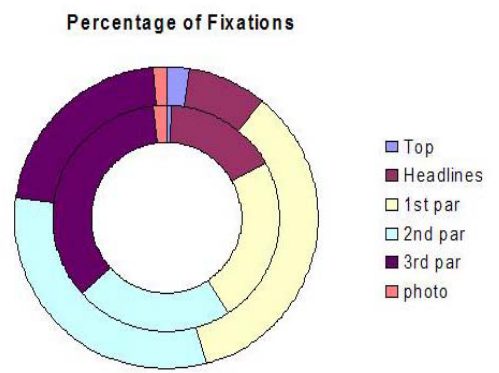
Figure 7 - Ring diagram that compares percentage distribution of fixations within AOIs during reading of the story text. Internal ring: Corriere della Sera, External ring: La